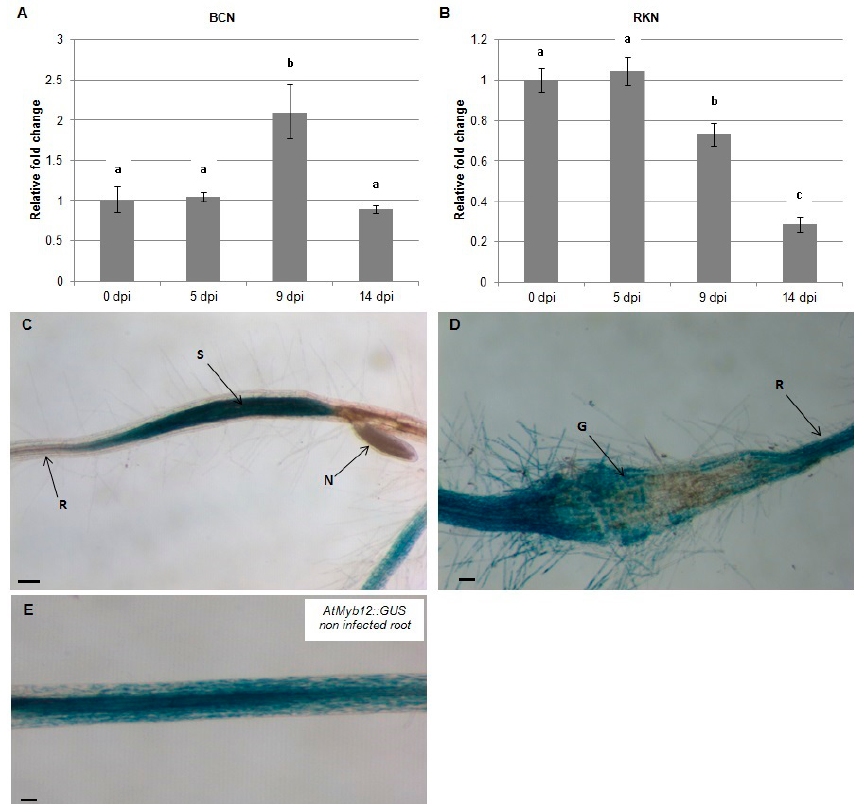
Figure 1. Temporal pattern of Arabidopsis AtMYB12 gene expression during nematode infection. AtMYB12 expression was quantified by qRT-PCR in roots of wild-type Arabidopsis plants at 0, 5, 9 and 14 dpi with the beet-cyst nematode, H. schachtii (BCN) ( A ) or the southern root-knot nematode M. incognita (RKN) ( B ). Histochemical localization of GUS activity directed by AtMYB12p::GUS fusion in H. schachtii- induced feeding sites ( C ) and in M. incognita -formed galls ( D ) at 9 dpi as compared to non-infected roots ( E ). G, gall; N, nematode; S, syncytium; R, Arabidopsis root . Quantitative expression analyses were normalized to the Arabidopsis Actin8 gene and presented relative to uninfected control tissue (baseline set at 1.0). Values are means ± SE (3 technical replicates) with different letters indicating significant differences between time points p < 0.05 (One- way ANOVA test). Similar results were obtained from two independent biological replicates. Scale bar = 200 μ m ( C ), and 100 μ m ( D , E ).